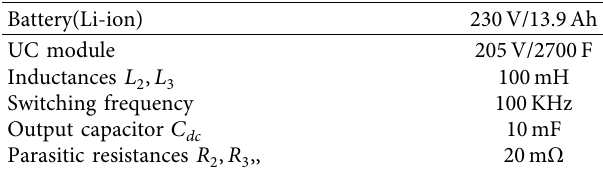
Table 2: Energy sources data.